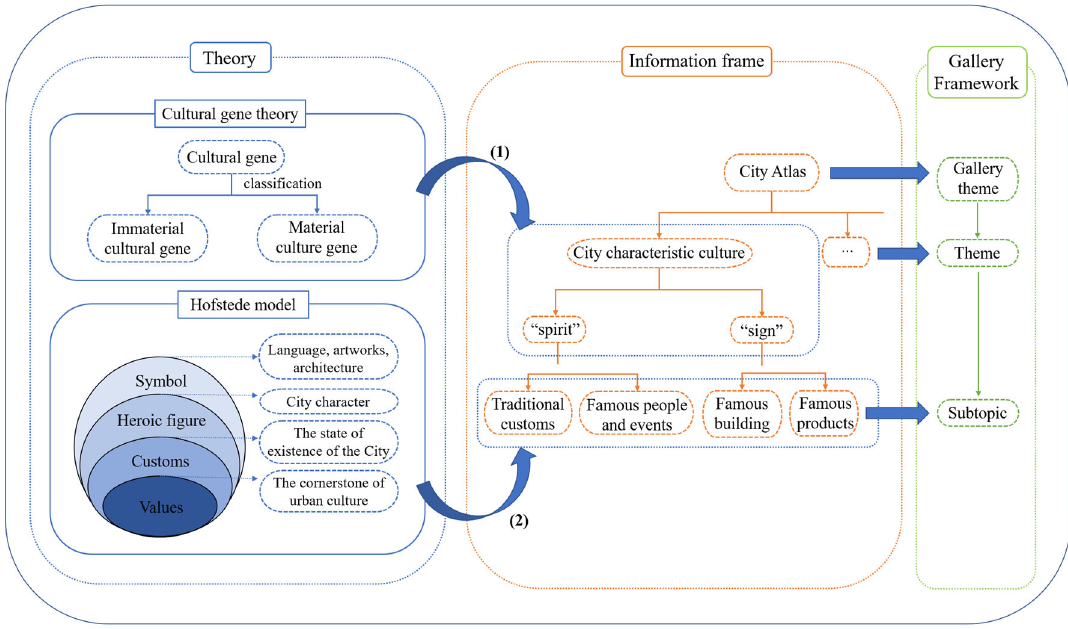
Figure 3. The content framework of city characteristic culture. ( 1 ) Initial delineation of the city’s characteristic culture by cultural gene theory; ( 2 ) Selection of city ‐ specific cartographic themes characteristic culture by cultural gene theory; ( 2 ) Selection of city-specific cartographic themes based based on the Hofstede model. on the Hofstede